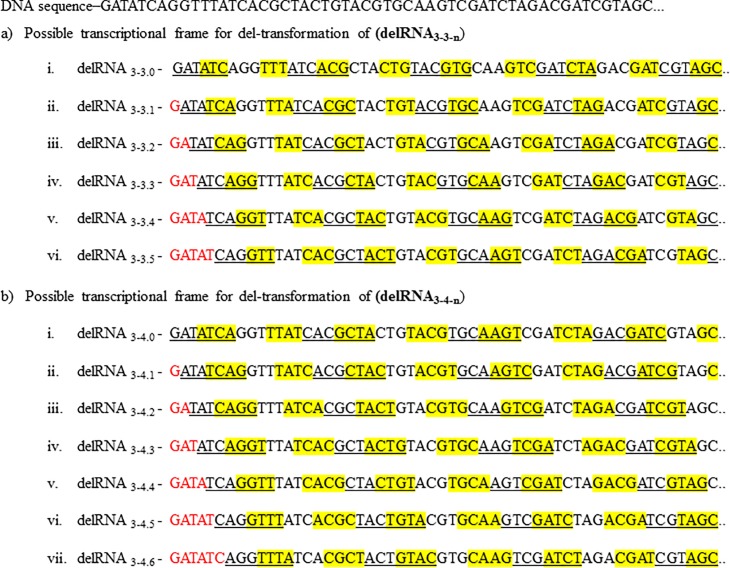
Mitogenomic versions of delRNA3-3 and delRNA3-4.Nucleotides highlighted yellow are deleted during transcription. (A) Possible mitogenomic versions for del-transcription window size six, k = 3 (delRNA3-3.n). (B) Possible mitogenomic versions for del-transcription window size seven, k = 4 (delRNA3-4-n). ‘n’: nucleotides deleted before del-transcription initiation assumed to cover all possibilities (highlighted red).